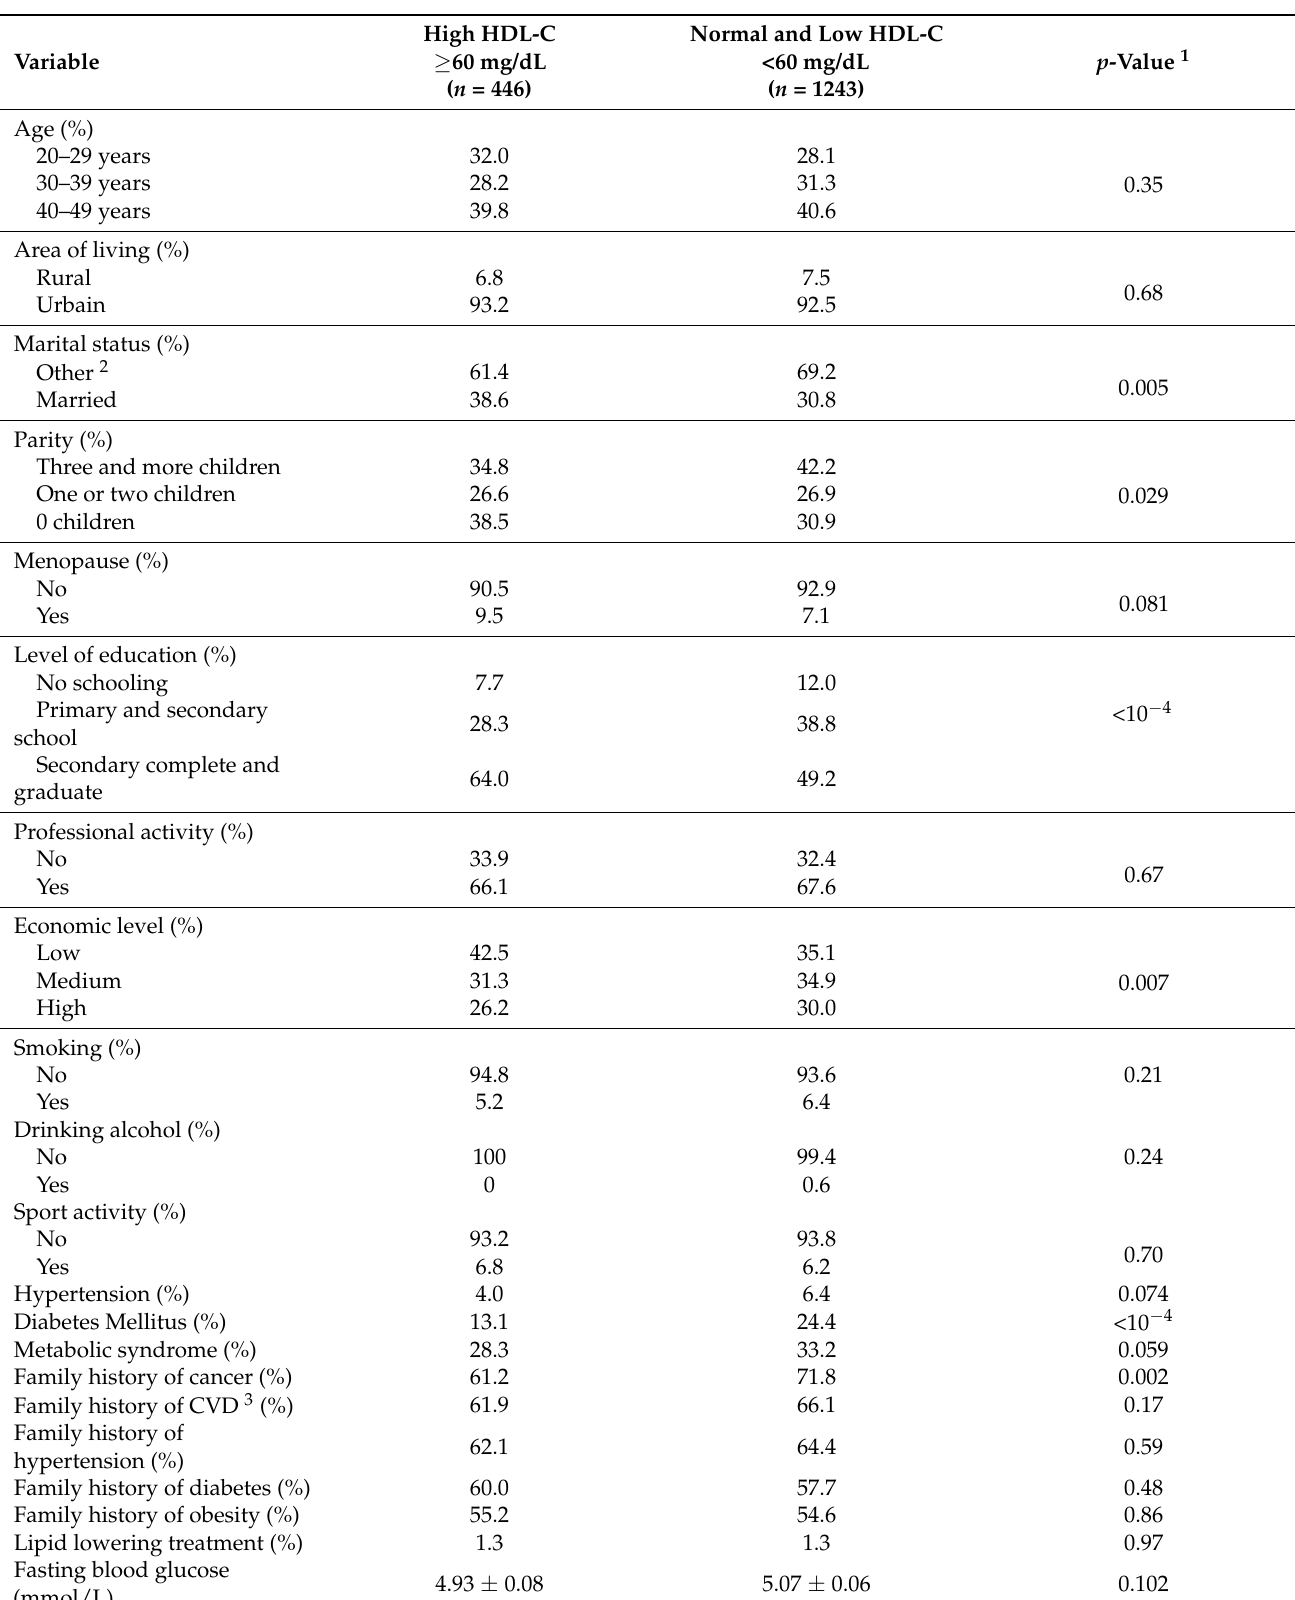
Table 1. Characteristics of Tunisian women according to HDL-C